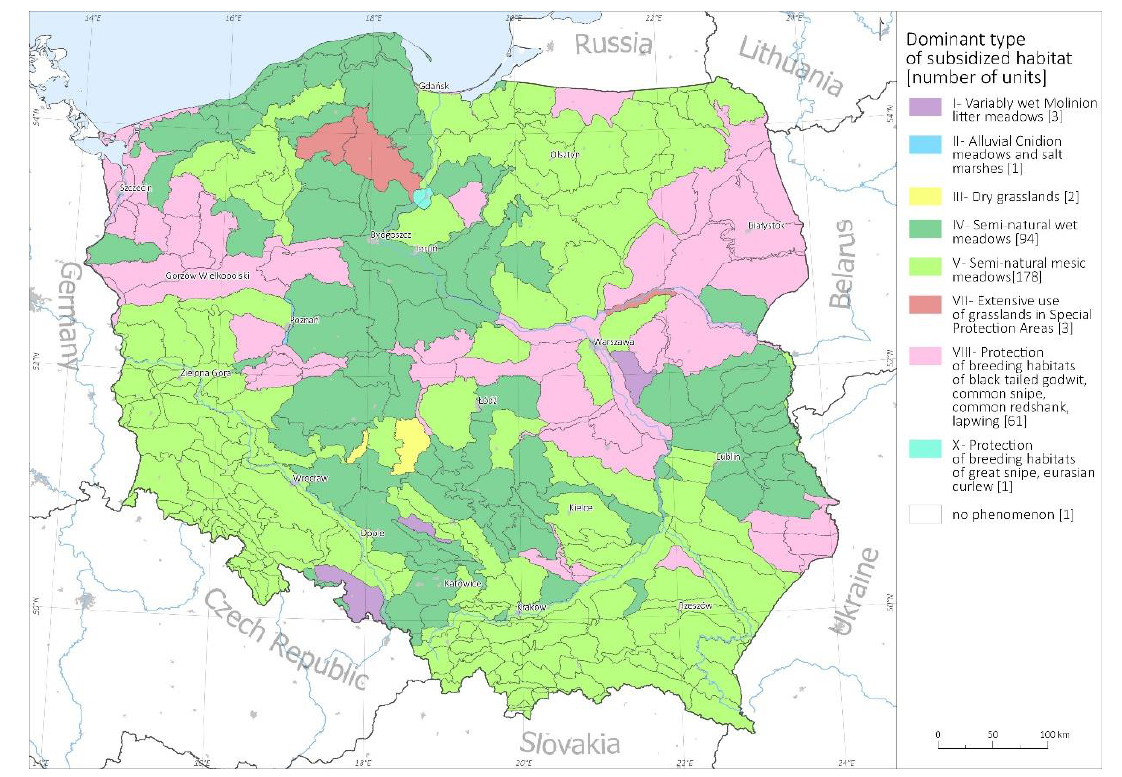
Figure 16. Dominant subsidised habitat types in mesoregions (Source: Authors based on ARMA data).